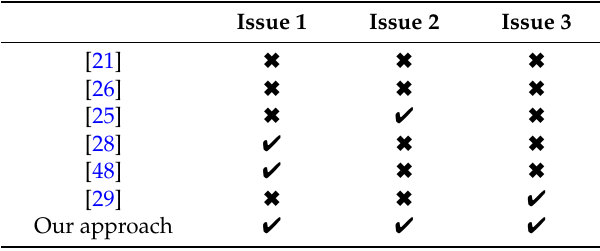
Table 2. Comparison of the issues addressed by our approach against current related work. ‘Issue 1‘ discovers full or partial patterns, ’Issue 2‘ is the ability to do this based on one database scan, and ‘Issue 3‘ represents the ability to generate correlated periodic-frequent patterns. The symbol ‘ (cid:52) ’ indicates that the issue addressed and ‘ (cid:54) ’ indicates that the issue is not addressed by the corresponding